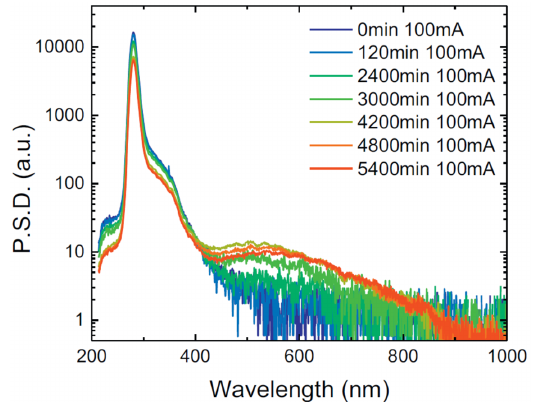
Figure 10. Spectrum variation during 500 mA stress test. Reproduced with permission. [48] Copyright 2018, Elsevier. Pinos et al. studied the emission spectrum from a 285 nm AlGaN quantum well light- emitting diode (QW-LED). The results indicated that certain regions (which are microm- eter-sized, domain-like areas) having lower AlN molar fractions pour out light with higher intensity. Furthermore, the various experiments performed revealed that intensity from these regions raised with time and a redshift in wavelength is observed [49]. In an- other study, Pinos et al. described the degradation under the influence of elevated current stress of AlGaN quantum well-based LEDs pouring out light of 285 and 310 nm wave- length. The results revealed that elevated concentration of nitrogen-vacancy and tunnel- ing current as well as partial reimbursement of the p-doping caused to decrease in the emission intensity during the aging process [50]. Jan Ruschel et al. investigated the deg- radation in UV-LEDs for 1000 h of stress [51]. The influence of operation current within the range 50–300 mA was also studied in comparison to current densities in the particular range from 34 A/cm 2 to 201 A/cm 2 . In aging operations, the optical power reduction was robustly speed-up for higher current [52,53]. Matteo Meneghini et al. explored DUV-LEDs and analyzed the reliability at a DC stress of 20 mA. In response to aging, the devices intimated a lesser optical power [39].